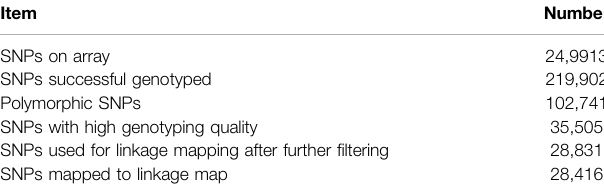
TABLE 2 | SNPs selected for linkage mapping.